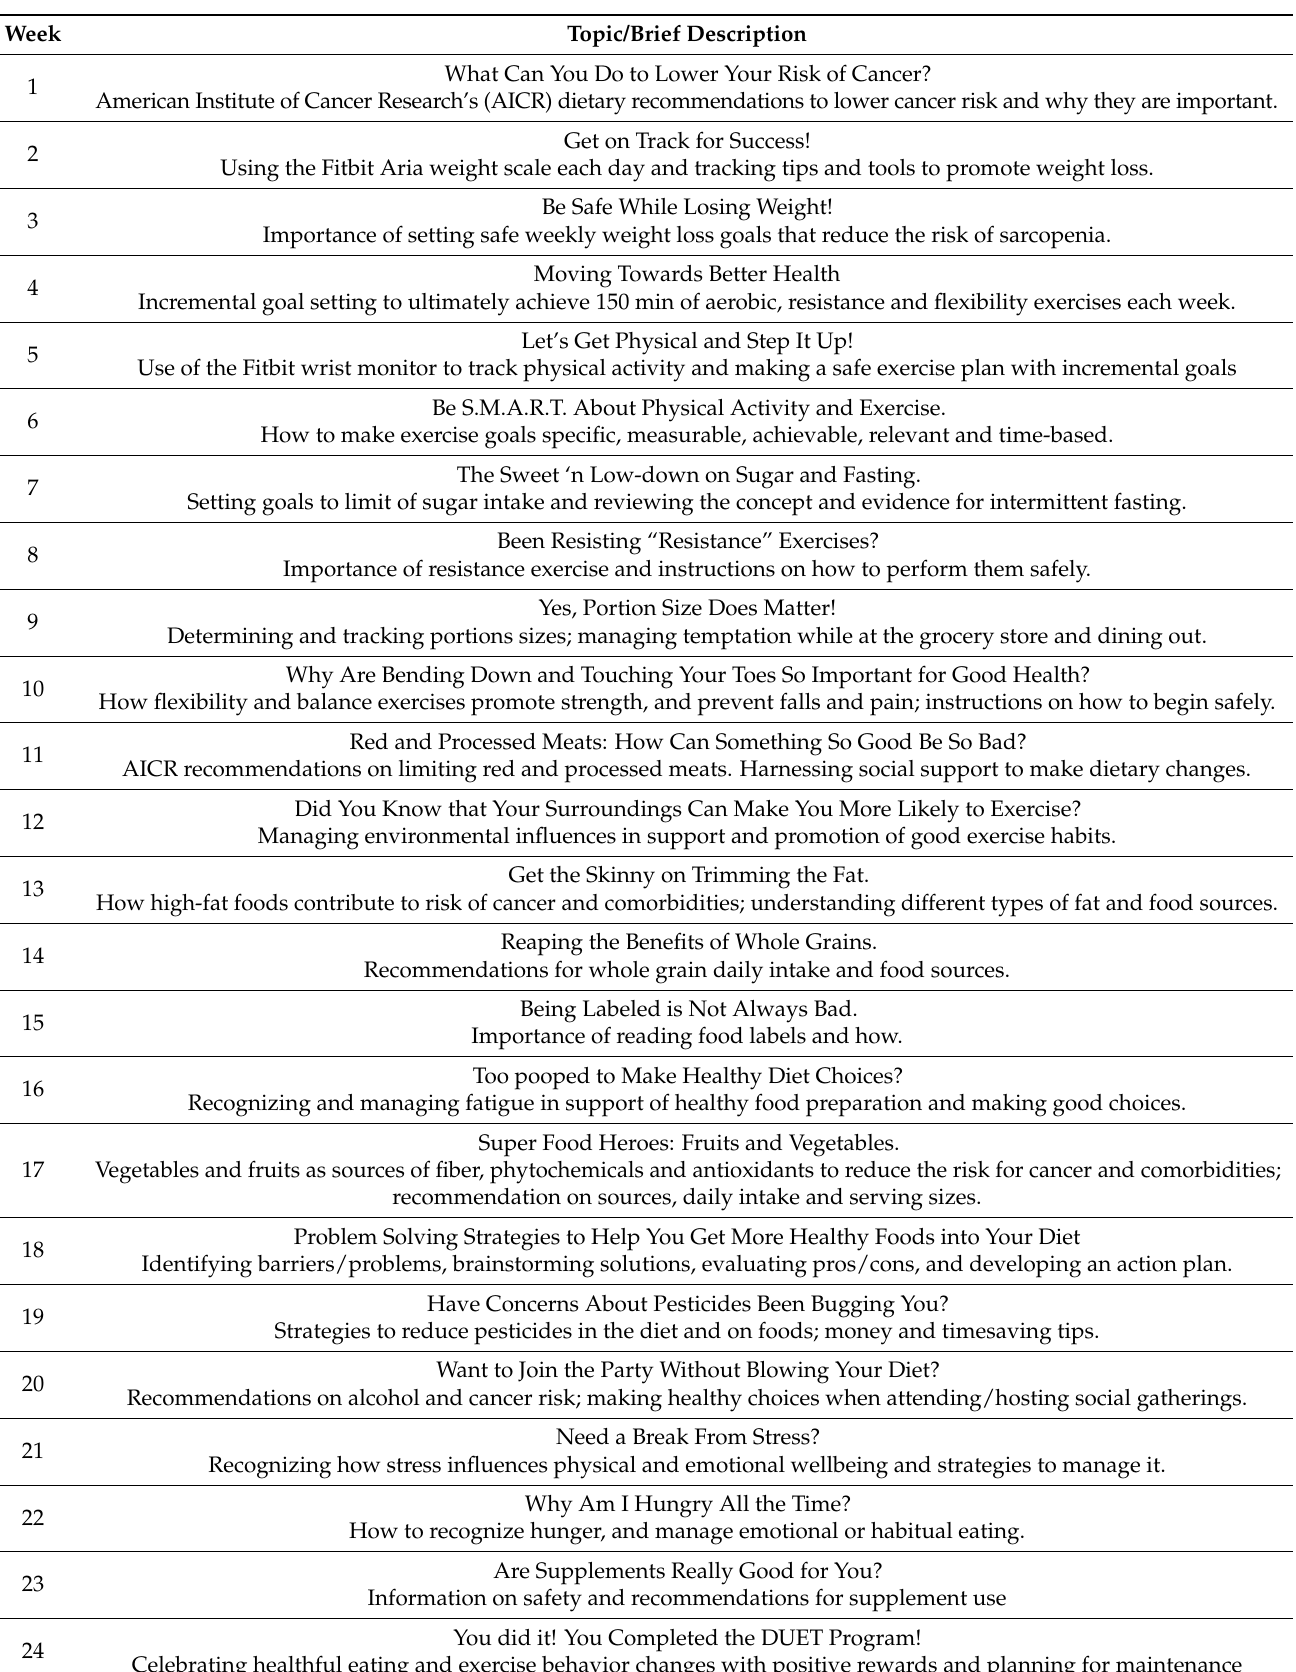
Table 1. DUET diet and exercise